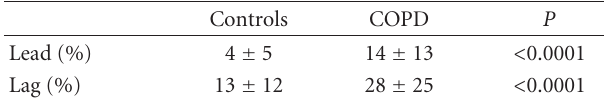
Table 3: The means ± standard deviations of lead and lag expressed as a percent of the duration of inspiration at the trachea.